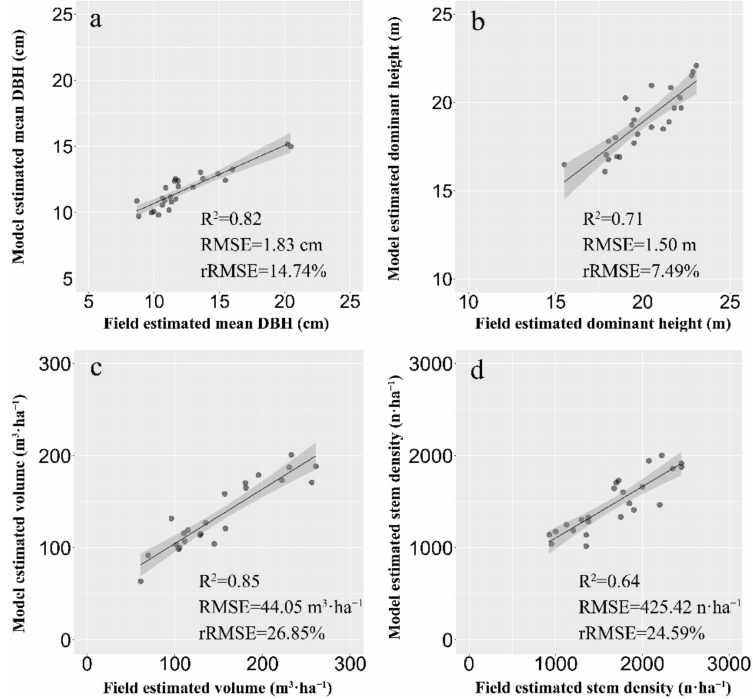
Figure 6. The scatterplots of two-stage extrapolation models of the validation plots used to assess model accuracy. Subfigures ( a – d ) represented the scatterplots of mean DBH, dominant height, volume and stem density, respectively.